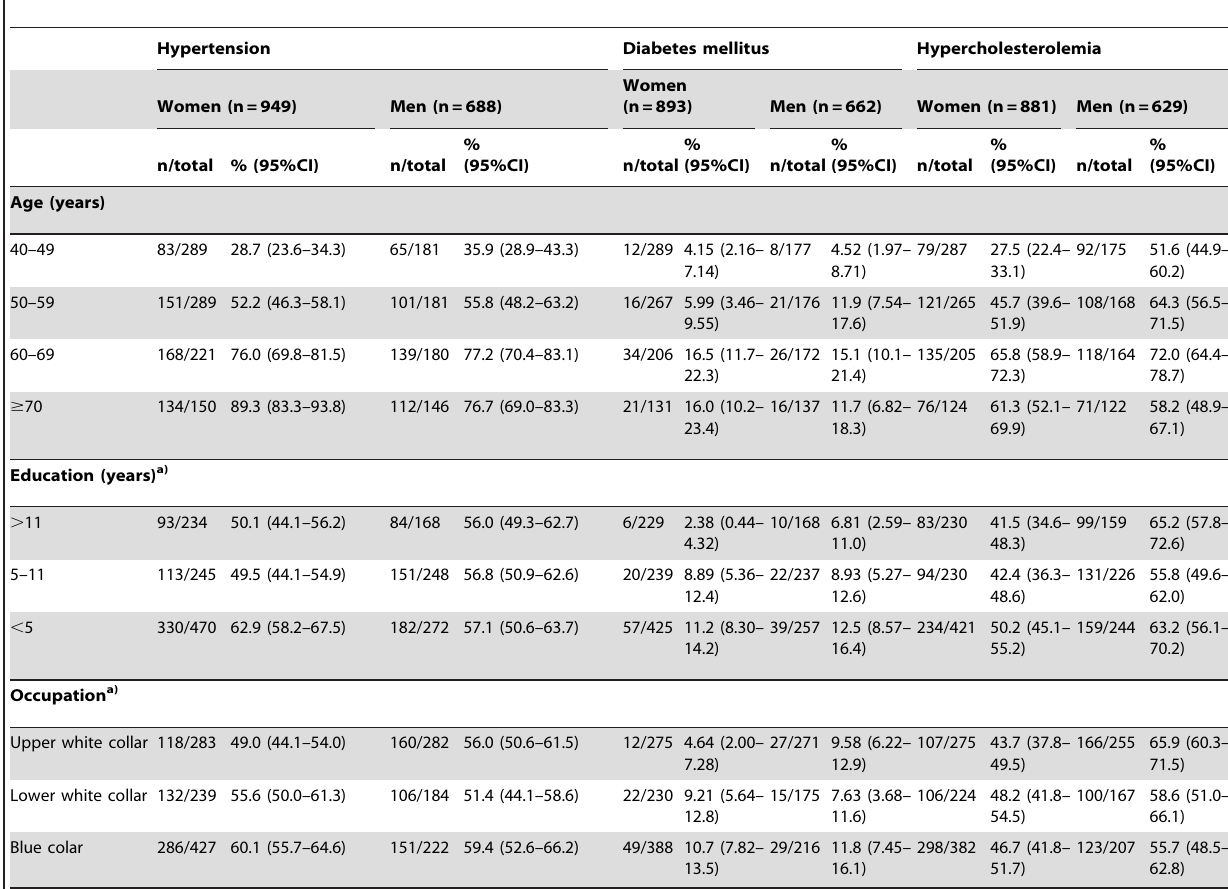
Table 2. Prevalence of hypertension, diabetes mellitus and hypercholesterolemia across age, education a) and occupation a)